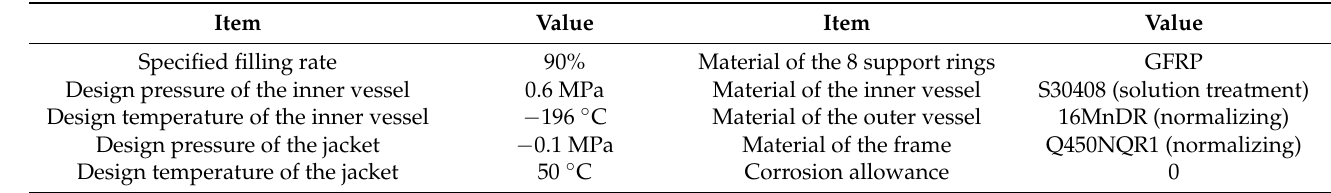
Figure 1. Schematic diagram of the tank container. Table 1. Main design parameters of the tank container.